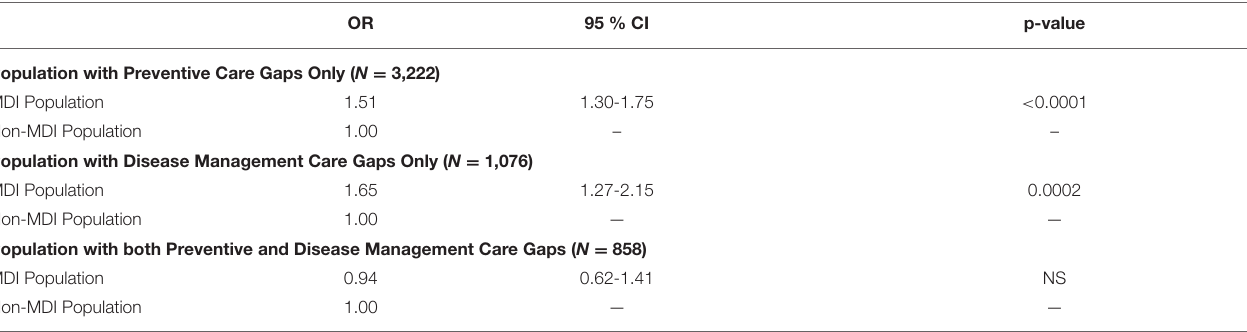
TABLE 2 | Logistic Regression Analysis of Medical Care Gap Closure a , by Care Gap